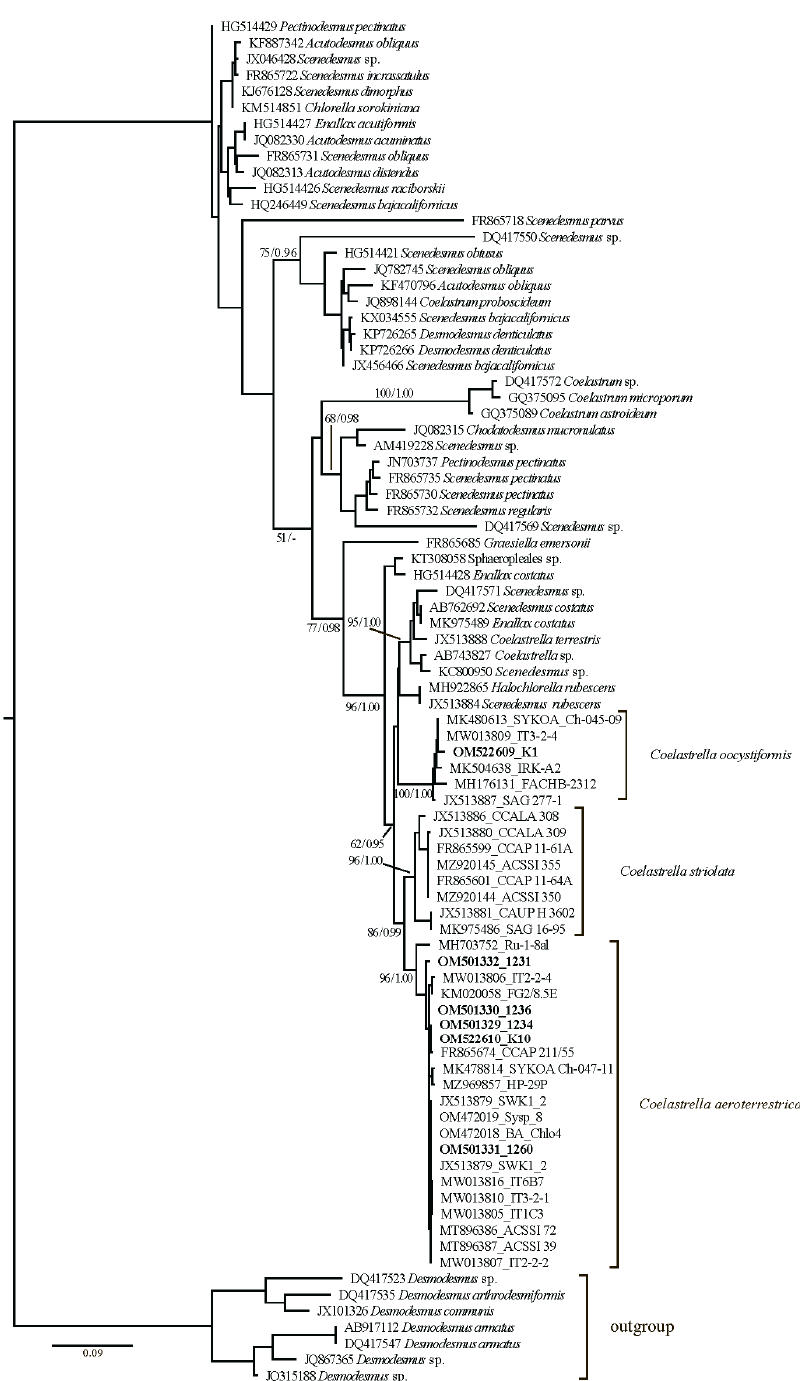
Figure 4. ML phylogenetic tree inferred in RAxML with a GTR+I+G nucleotide substitution model using 84 ITS rRNA sequences (626 characters). ML BP (>50%) and BI PP (>0.95) are shown. The newly obtained sequences are given in bold. Scale bar: substitutions per nucleotide position. Two species of Elliptochloris were found: Elliptochloris cf. subsphaerica (Table 2, Figure